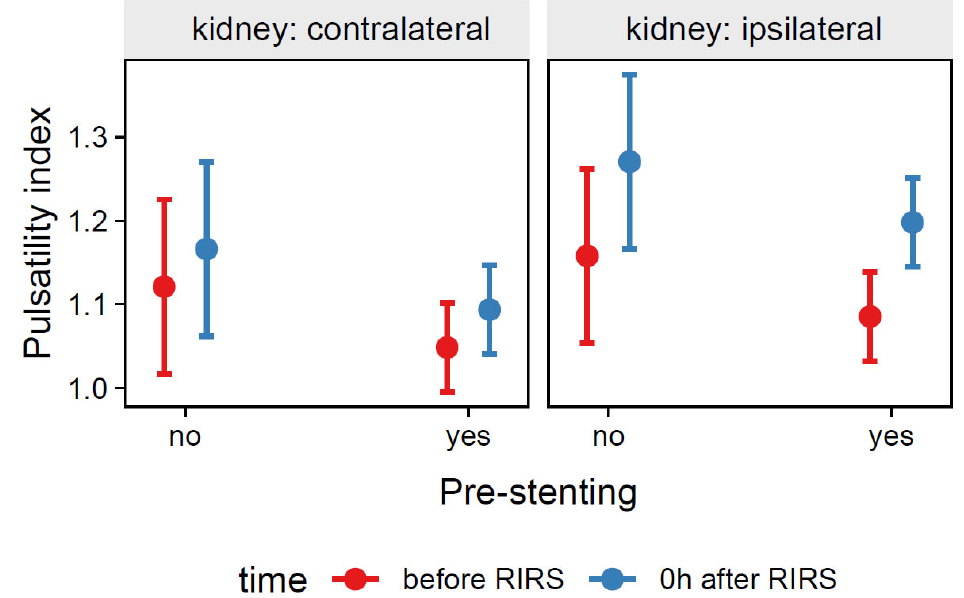
Figure 8. Predicted values (marginal effects) of resistive index by the Mod6 regression model for pre-stenting, time and kidney side terms.